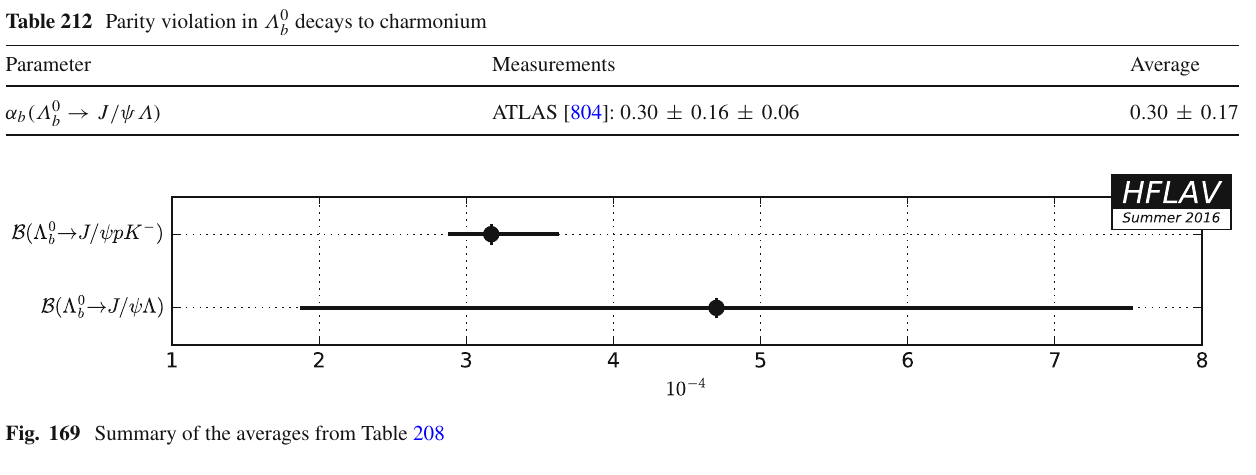
Table 212 Parity violation in Λ 0